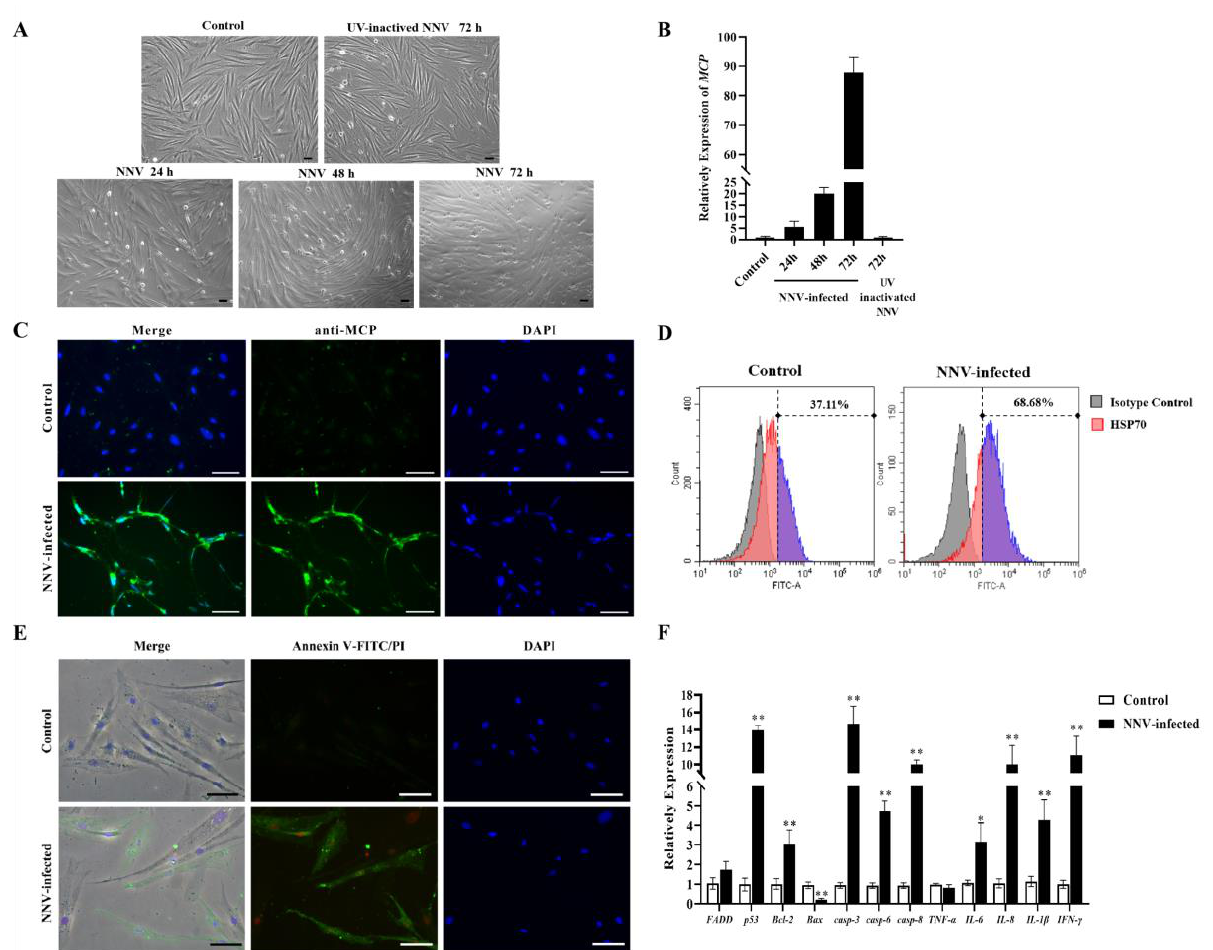
Figure 4. CAB cells infected with NNV. ( A ) CPE of CAB cells infected with NNV (MOI = 10) were observed at 24, 48, and 72 hpi, respectively, compared with PBS control and UV-inactivated NNV infected cells. ( B ) Analysis of MCP mRNA expression in NNV-infected CAB cells at 24, 48, and 72 hpi, compared with PBS control and UV-inactivated NNV at 72 h. ( C ) NNV replication in cells detected by immunofluorescence microscopy. The upper row shows uninfected CAB cells (control), whereno fluorescence staining was observed; the lower row shows NNV-infected CAB cells, in which strong fluorescence signal was observed in the virus-infected cells. ( D ) Flow cytometric analysis of HSP70 expression in CAB cells infected with or without NNV at 24 h. Fluorescence histogram illustrates HSP70 expression, and the gate was applied using an isotype control. Anti-HSP70 antibody and Alexa-488 labeled secondary antibody were used for probing. The color purple represented the relatively expression level of HSP70. ( E ) Cell apoptosis was detected using annexin V-FITC/PI staining in CAB cells infected with PBS (upper) and NNV (lower) after 24 h. Green and red fluorescence represents early- and late-stage apoptosis, respectively. Scale bar = 50 µ m. ( F ) The mRNA expression of inflammatory factor genes and apoptosis-related genes in CAB cells infected with NNV. The CAB cells infected with NNV at 24 h were collected and the total RNA was extracted. Expression levels of proinflammatory cytokines and apoptosis-related genes were determined by qRT-PCR, with the expression level of each gene of the PBS control group as 1. EF- α was selected as the reference gene. Data in this assay is expressed as mean ± SD ( n = 3). n , the number of cell wells used in the experiment. (** stands for p < 0.01; * stands for p < 0.05.).